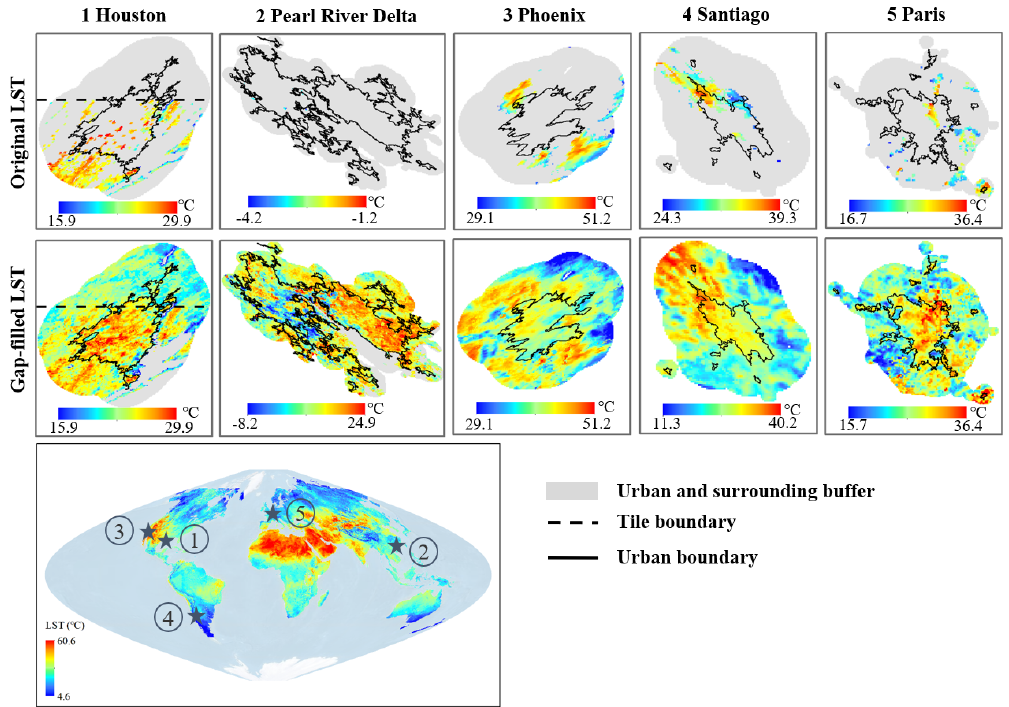
Figure 7. Spatial pattern of the original and gap-filled LSTs in five representative cities. NA (gray color) in the gap-filled LST is water pixels. Solid black lines are the boundary of urban regions extracted by using global artificial impervious area data with 30m spatial resolution (Li et al.,